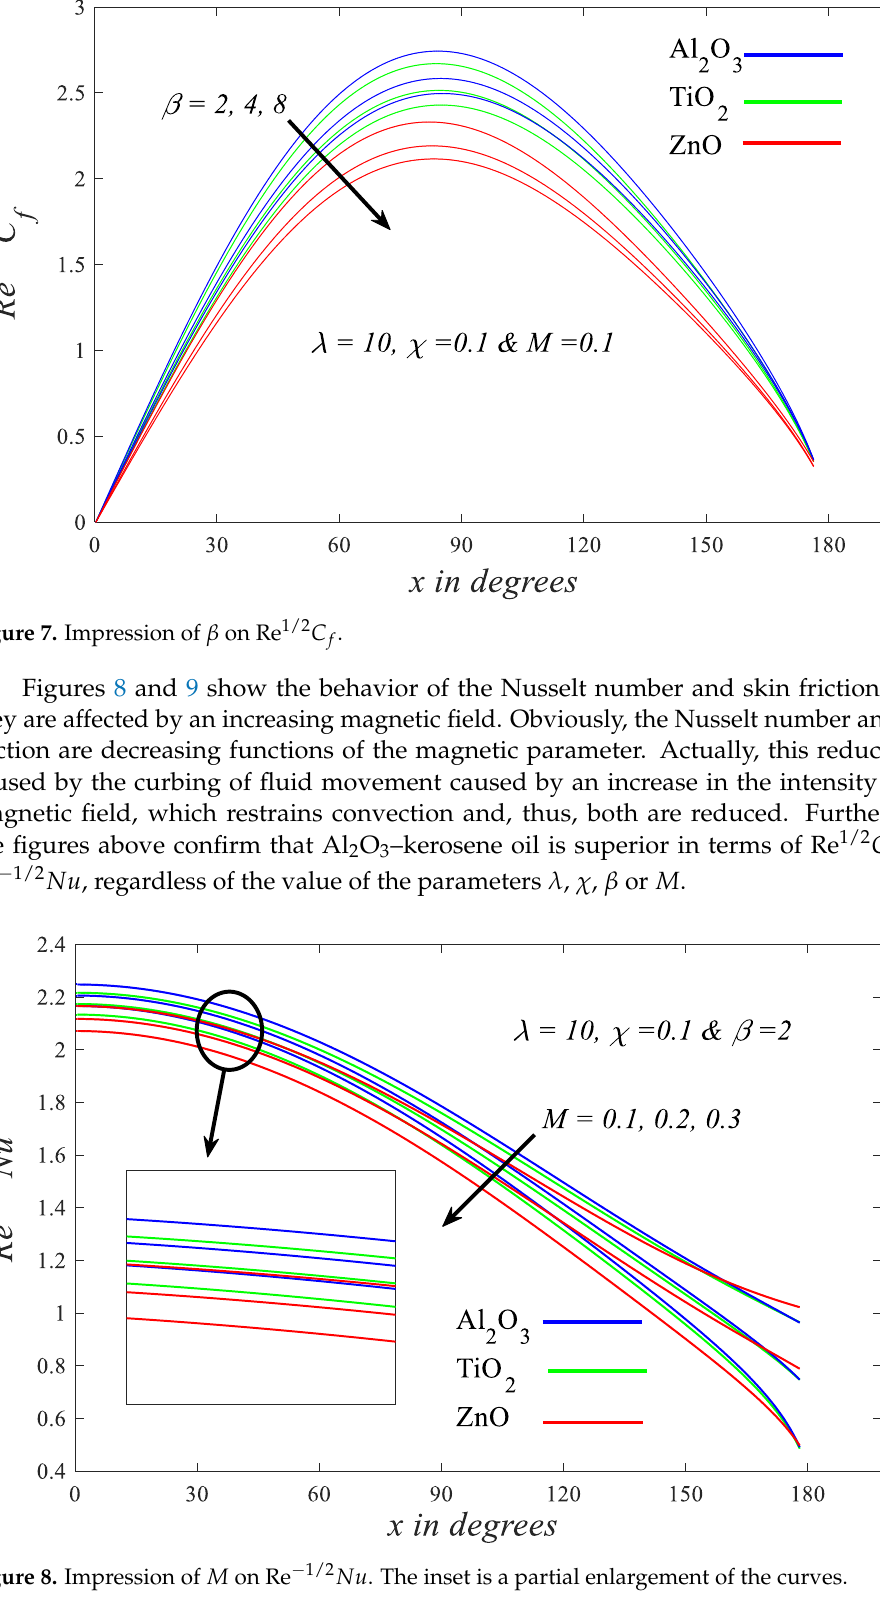
Figure 6. Impression of  on 1/2 Re  Nu . The inset is a partial enlargement of the curves.